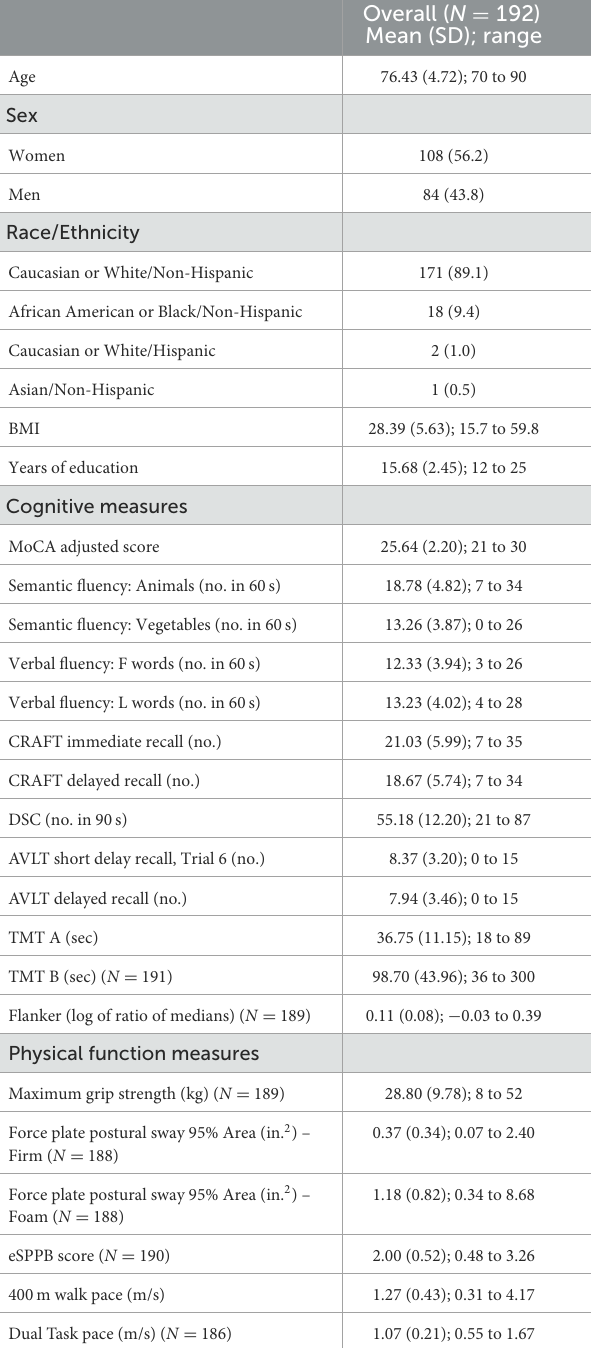
TABLE 1 Descriptive statistics from participants at baseline in the BNET